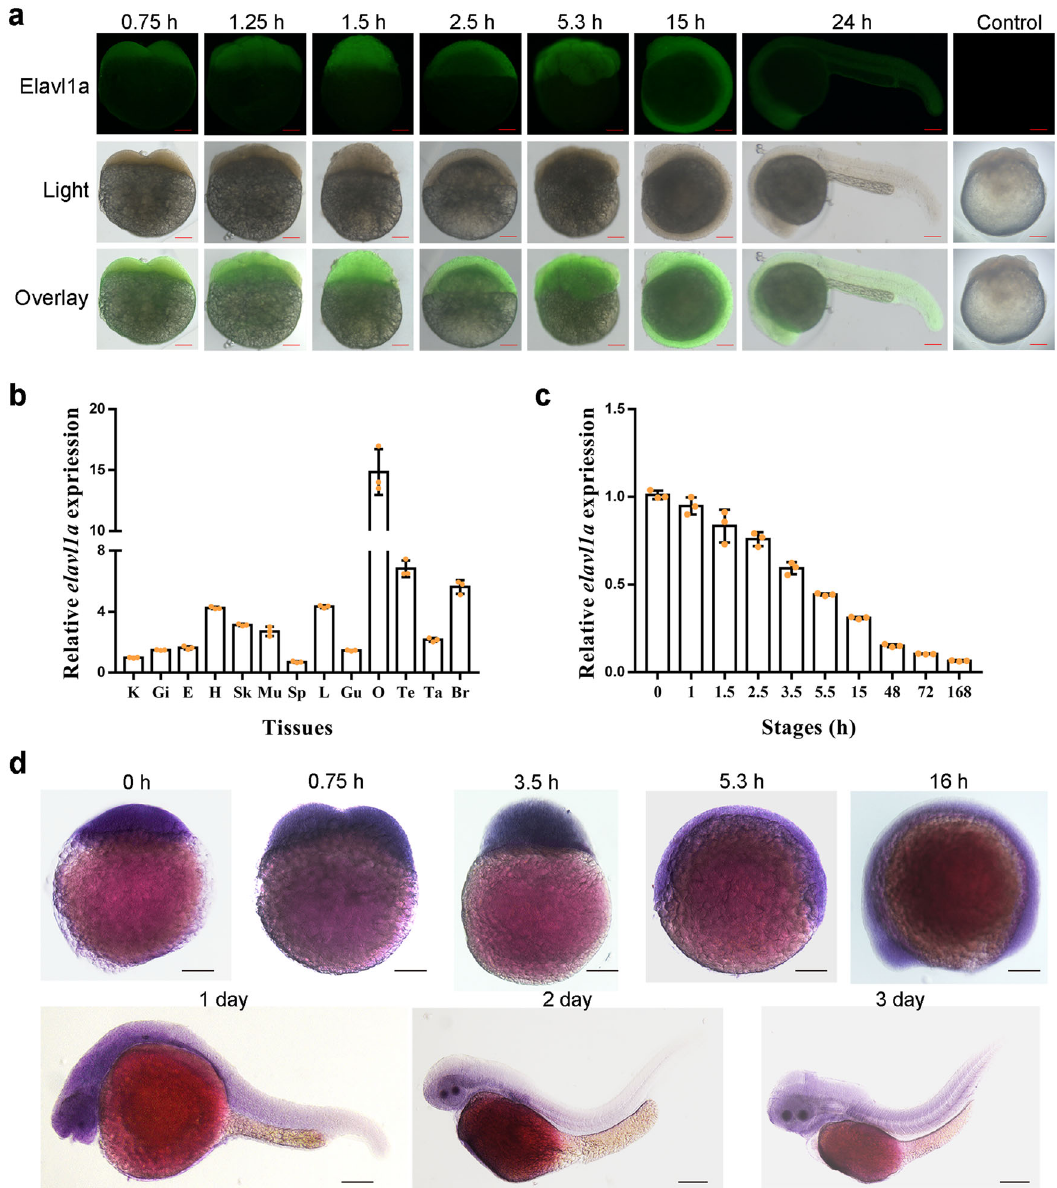
Fig. 2 Distribution of zebra fi sh ELAVL1a in the cells of different developmental stage embryos and expression patterns of zebra fi sh elavl1a in the different tissues as well as at the different developmental stages. a Immunohistochemical localization of ELAVL1a in the different developmental stage: 2-cell stage (about 0.75 h); 8-cell stage (~1.25 h); 16-cell stage (~1.5 h); 256-cell stage (~2.5 h); 50% epiboly stage (~5.3 h); 10-somite stage (~15 h); 24-h post-fertilization (24-hpf); Control: 16-cell embryo incubated with mouse pre-immune serum as control. Scale bars represent 100 μ m. b Expression pro fi les of zebra fi sh elavl1a in the different tissues including kidney (K), gill (Gi), eye (E), heart (H), skin (Sk), muscle (Mu), spleen (Sp), liver (L), gut (Gu), ovary (O), testis (Te), tail (Ta), and brain (Br). c Expression pro fi les of zebra fi sh elavl1a at the different developmental stages including zygote (0 h), 4-cell stage (about 1 h), 16-cell stage (~1.5 h), 256-cell stage (~2.5h), high blastula stage (~3.5 h), 50% epiboly stage (~5.5 h) embryos, 10-somite stage (~15 h), 2-day post-fertilization (2-dpf), 3-dpf, and 7-dpf larvae. β -actin was chosen as the internal control for normalization. Relative expression data were calculated by the method of 2 − ΔΔ Ct . The vertical bars represent the mean ± SD ( n = 3). The data are from three independent experiments performed in triplicate. d Expression of elavl1a during early development detected by WISH. Stages of embryonic development: newly fertilized egg (0 h); 2-cell stage embryo (~0.75 h); high blastula stage embryo (~3.5 h); 50% epiboly stage embryo (~5.3 h); 14-somite larvae (16 h); 1-day-old larvae; 2-day-old larvae; 3-day-old larvae. The color of the positive signal is